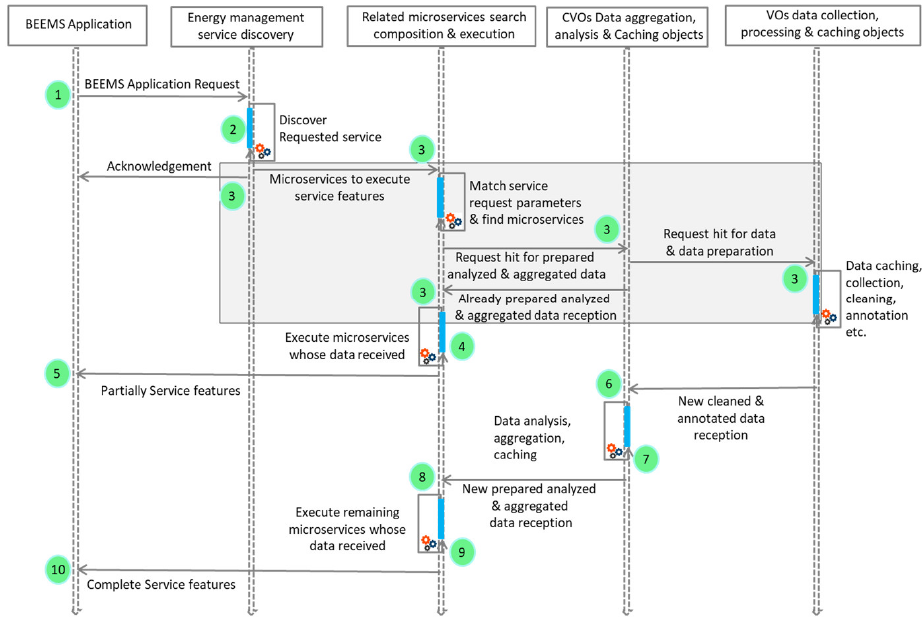
Figure 2. Interactions among the microservices-based modules in the WoO layered architecture to improve the data availability for BEEMS.